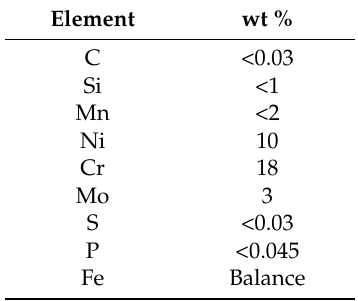
Table A1. Composition of stainless steel 316L (wt %) [34,35].